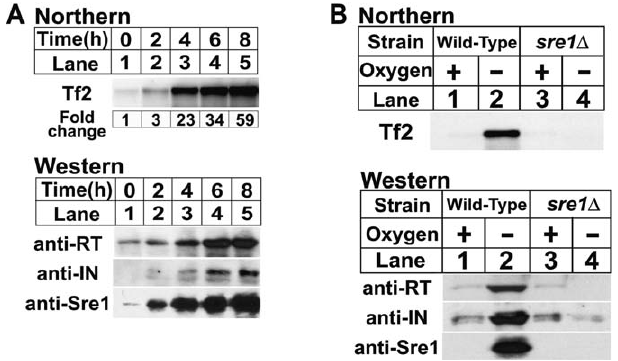
Figure 1. Low Oxygen Expression of Tf2 mRNA and Protein Requires Sre1 (A) Wild-type yeast were cultured in the absence of oxygen for increasing time. Upper panel: total RNA (10 l g) was subjected to northern analysis using a Tf2 probe. Lower panel: cell extracts (40 l g) were analyzed by immunoblotting using antibodies to Tf2 reverse transcriptase (RT), integrase (IN), and the nuclear form of Sre1 [23,27]. (B) Wild-type and sre1 D yeast were cultured þ / (cid:2) oxygen for 6 h and processed for northern and immunoblot analysis.